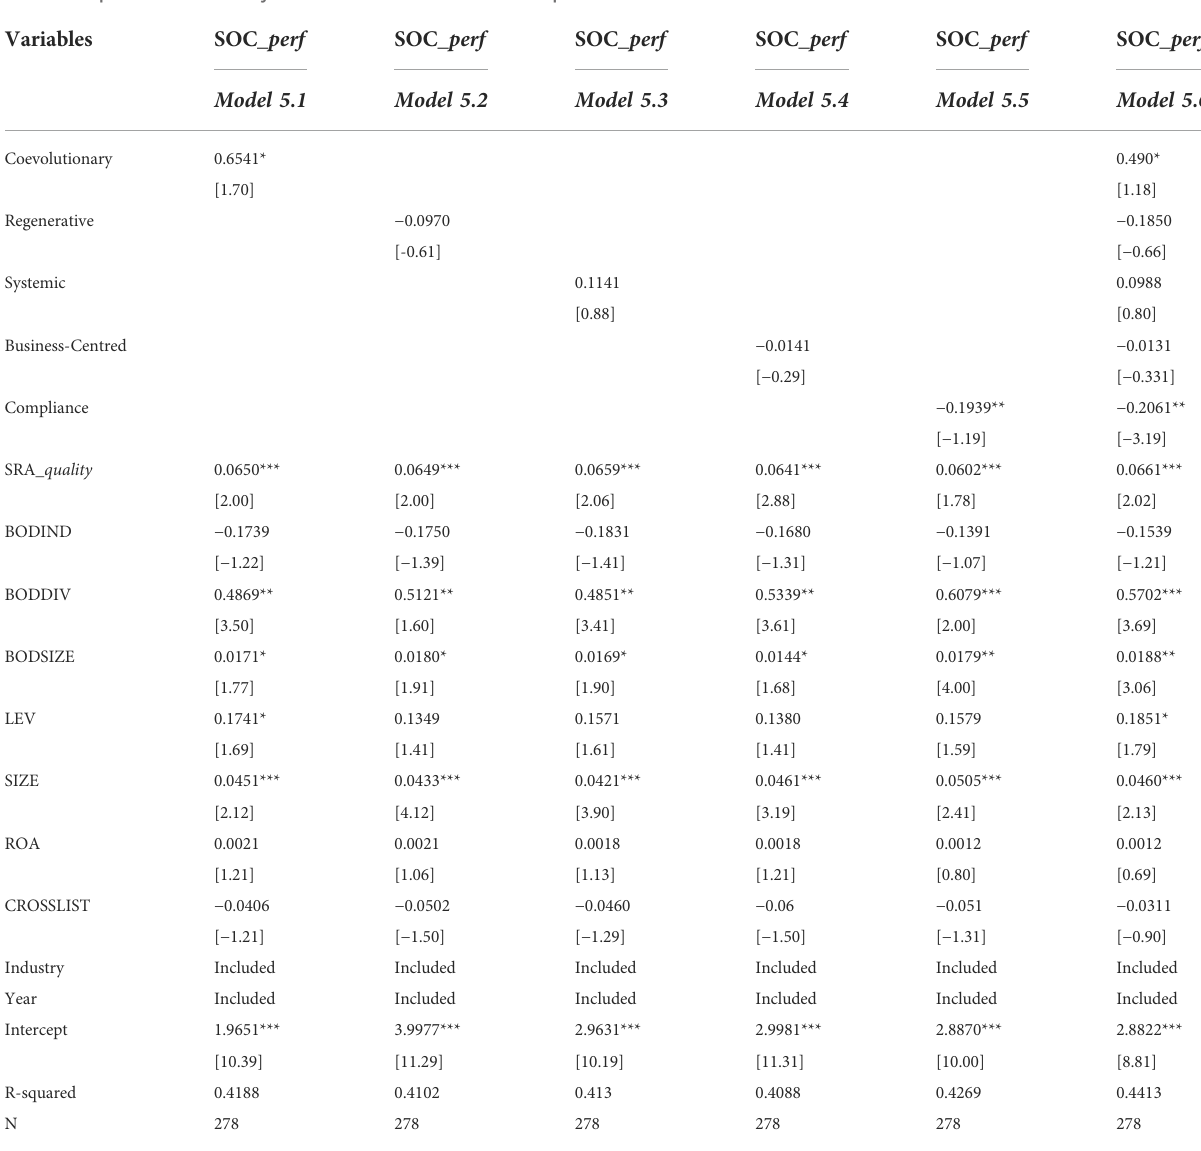
TABLE 5 Impact of sustainability communicative actions on social